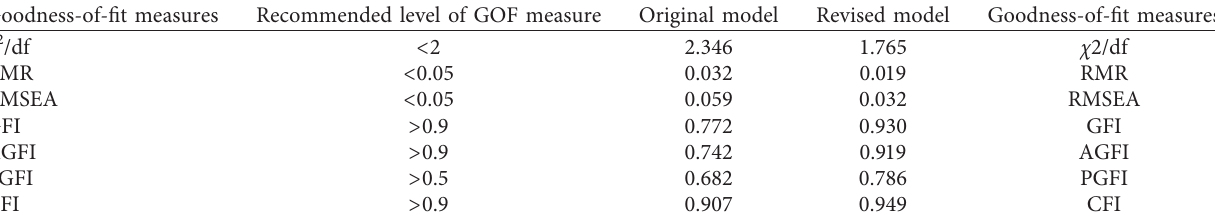
Table 4: Results of goodness-of-fit (GOF) measures.